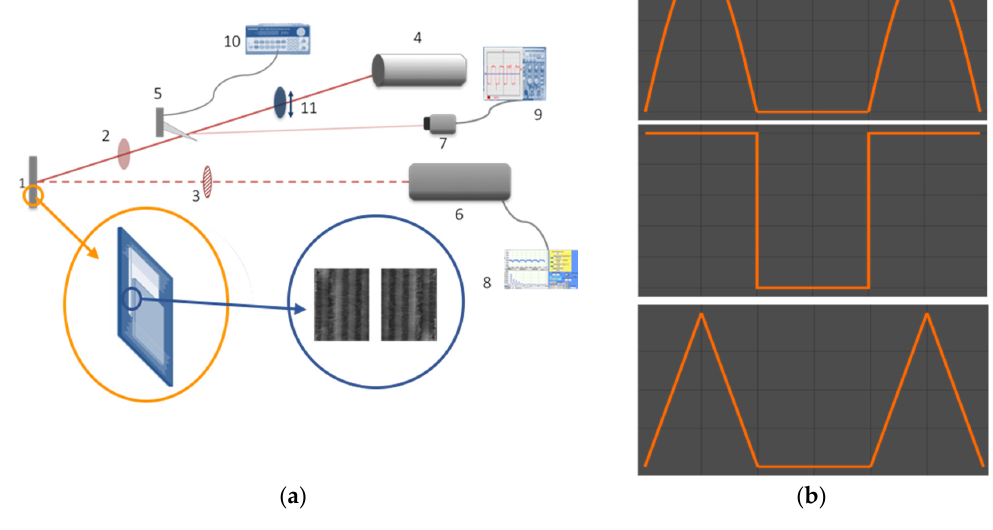
Figure 3. ( a ) Experimental setup: Photodyne (1), Neutral filter wheel (2), infrared band-pass (3), He-Ne Laser (4), mechanical chopper (5), vibrometer (6), photocell (7), computer (8), oscilloscope (9), function generator (10), and lineal polarizer (11). The drawing in the orange circle shows the mounted photodyne. A picture of the multilayers produced by SEM can be seen in the blue circle. ( b ) An example of ideal waveforms of the signals used in the experiments. From top to bottom: sinusoidal, rectangular and triangular.